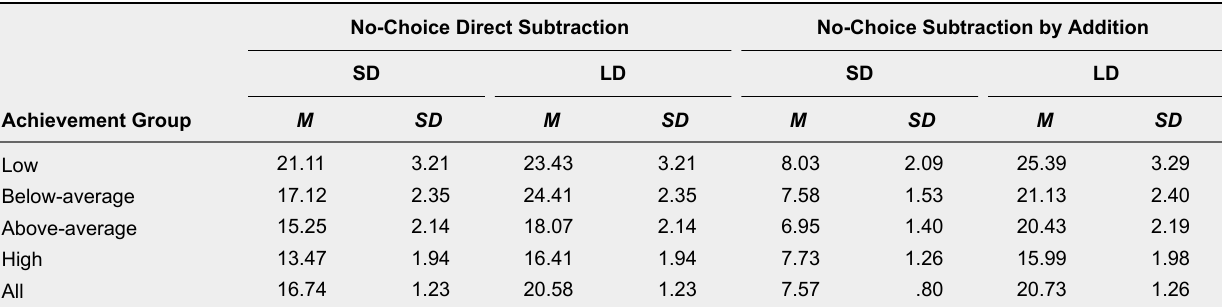
Speed (Seconds) of Strategy Execution in the No-Choice Conditions per Subtraction Type and Achievement Group (Least Squares